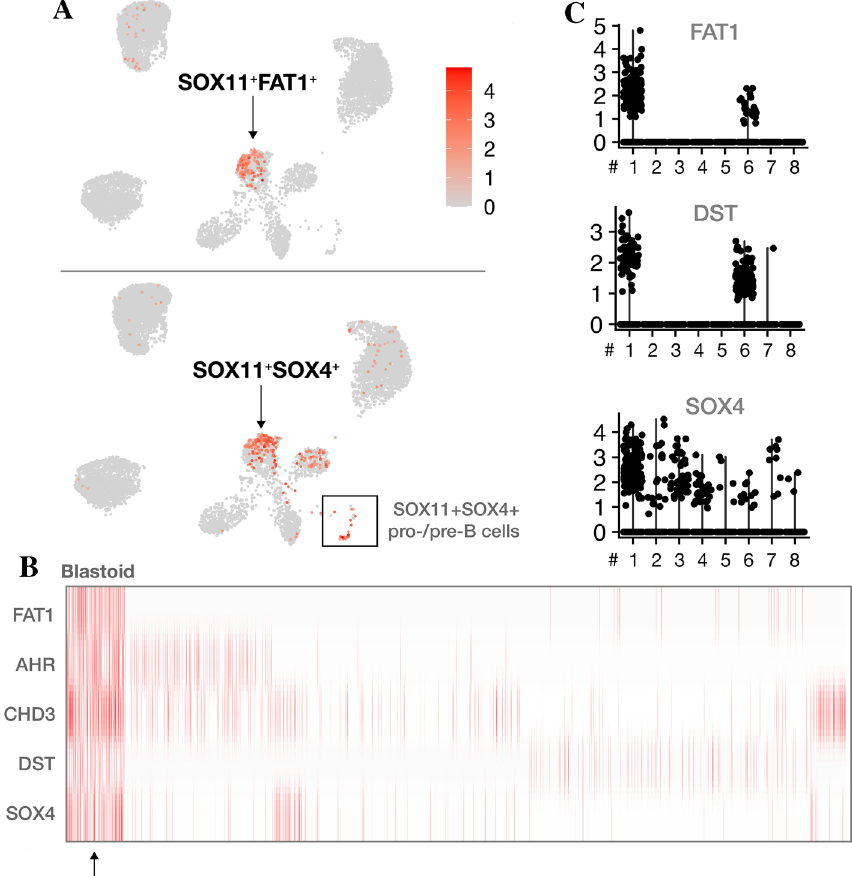
Figure 4. Expression signature of the blastoid mantle cell lymphoma case. Patient 1 had highly specific FAT1 expression (red, upper) among SOX11 + cells, while SOX4 expression (red, lower) was also found in pt. 3, 4, and 7 as well as in a small fraction of pro-/pre-B cells ( A ). A large fraction of these cells was also significant for an AHR + , CHD3 + , DST + , SOX4 + expression (red) signature ( B ), providing potential evidence of a more immature cell type based on previous findings in lymphoblastic leukemia/lymphoma. While the blastoid patient had a very high fraction of malignant SOX4 + cells, comprising 19.9% of the SOX11 + population and no evidence of healthy pro-/pre-B cells, it was not specific for SOX4 + cells in general. Violin plots show the expression (y-axis) of genes in each patient (x-axis) ( C